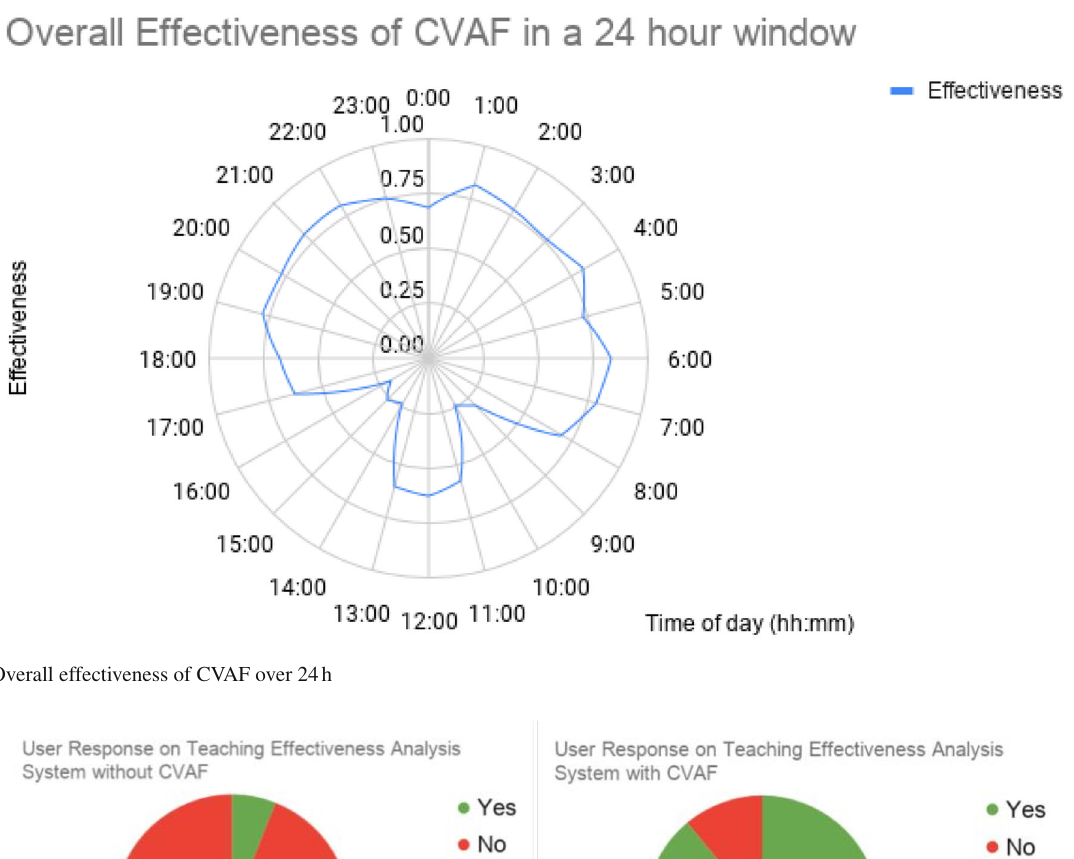
Fig. 10 Overall effectiveness of CVAF over 24h